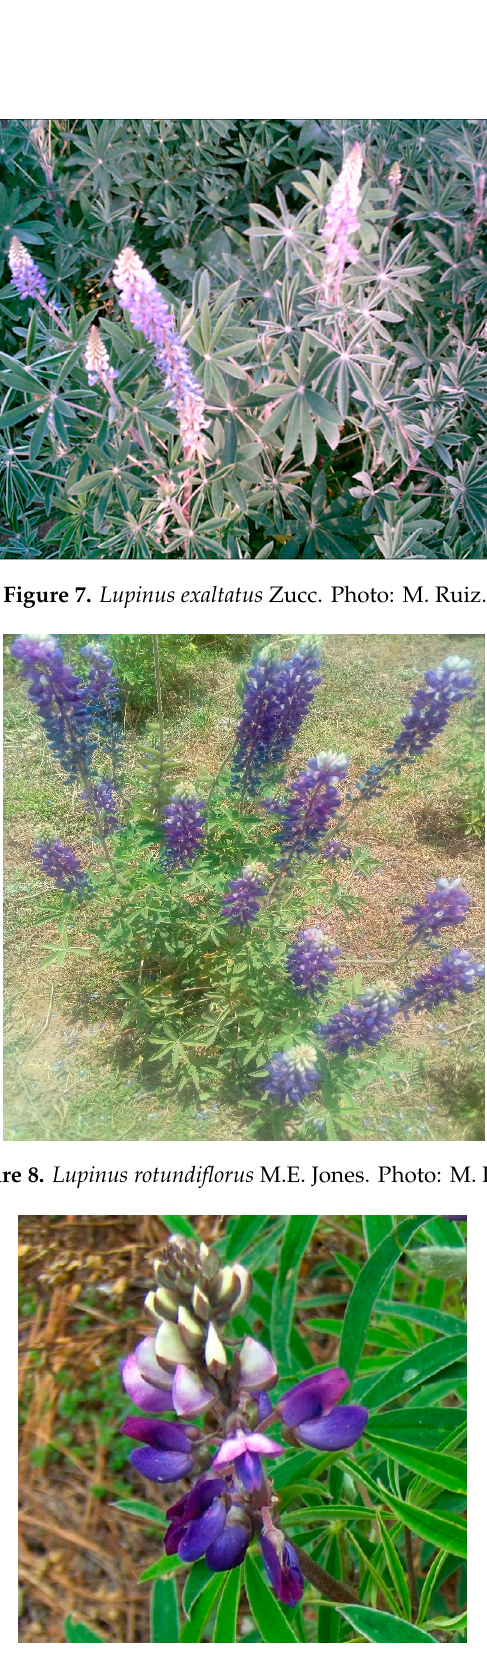
Figure 9. Lupinus aschenbornii S. Schauer. Photo: J. Ruiz.